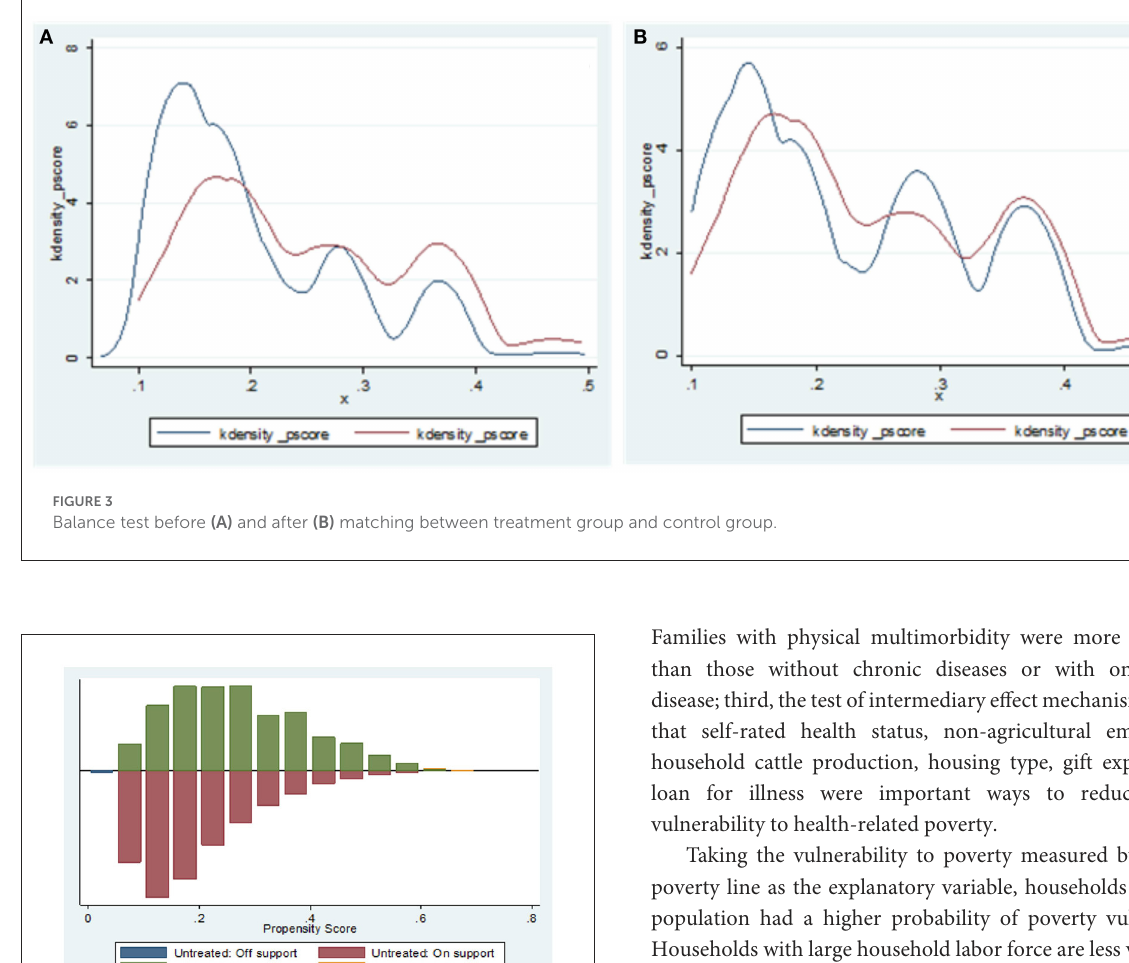
FIGURE4 Common support test after matching between treatment group and control group. Untreated off support = 15; Treated off support =